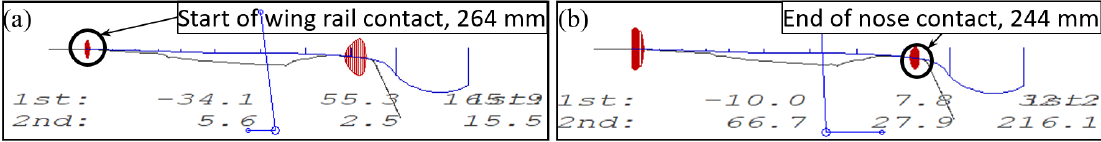
Figure 26. Simulation results of the 1:9 trailing crossing with rail wear and deformation taken into account. To analyze the developments in the wheel – rail interaction, the contact forces in both the designed and degraded conditions were also compared. The results are presented in Figure 27. Besides the dramatically increased impact force (438 kN in the degraded condition vs. 270 kN in the designed condition), the rail damage resulted in the loss of wheel – rail contact in the 0.27 – 0.46 m